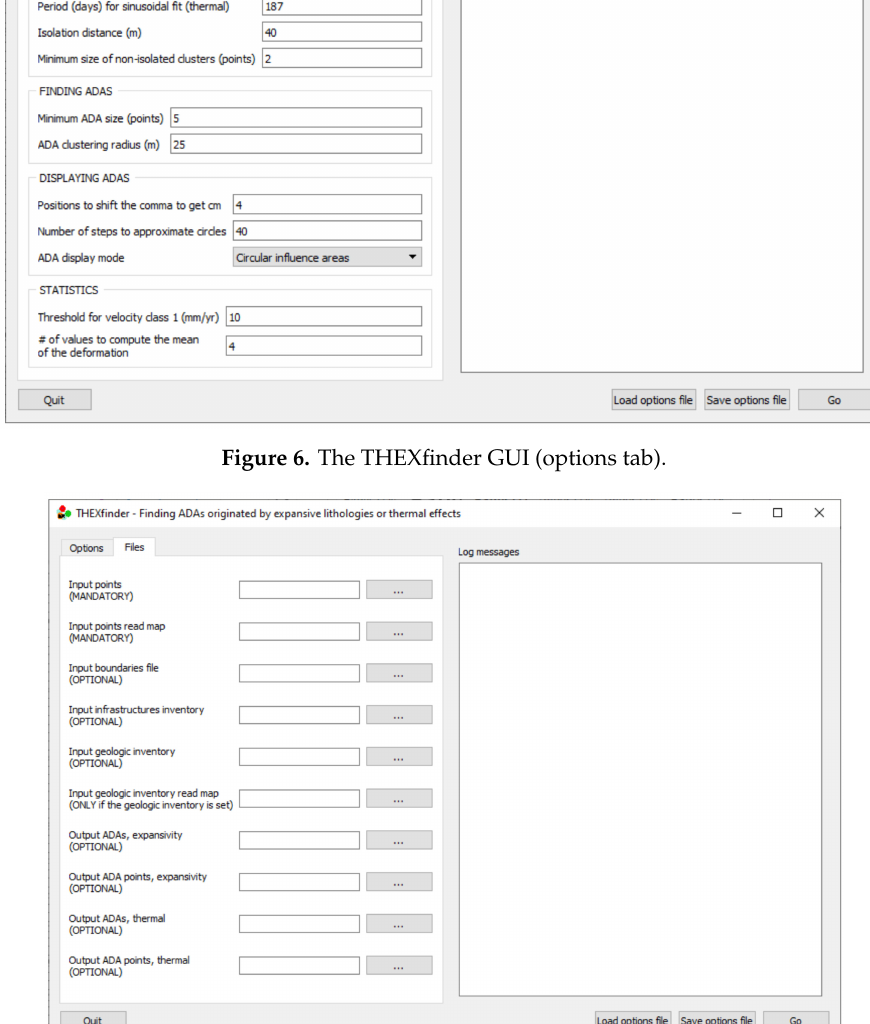
Figure 7. The THEXfinder GUI (files